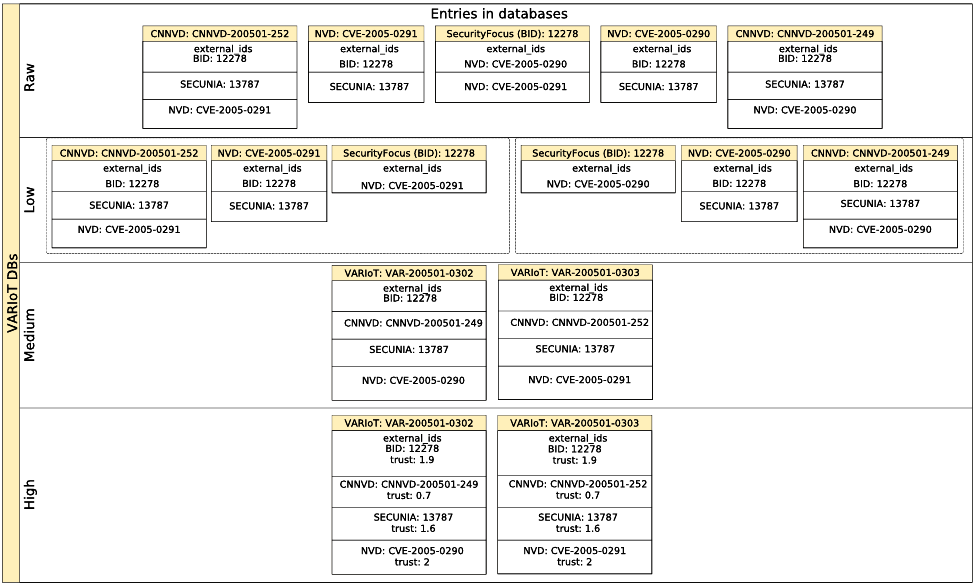
Figure 3. Process of merging entries from raw databases into a high database entries on the basis of external